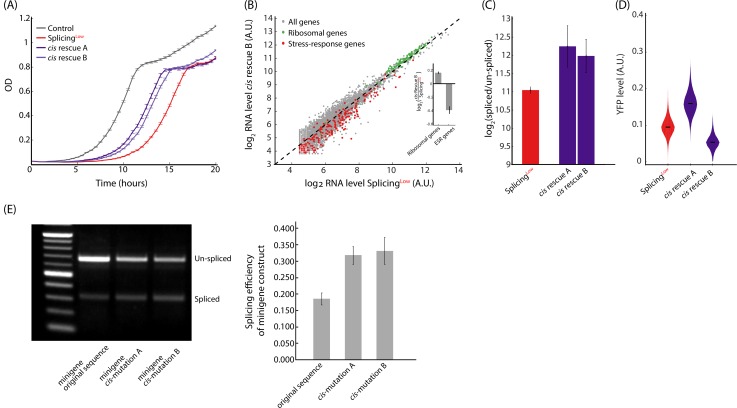
Cis-acting mutations are sufficient to increase fitness by elevating splicing efficiency.(A) We created two Cis-rescue strains, each harboring one of the mutations that appeared spontaneously in the evolved populations. Growth of the two Cis-rescue strains show that a single mutation in the YFP-Kan construct is sufficient to increase fitness compared with SplicingLow. (B) The exonic mutation is also sufficient to alleviate stress, as ribosomal genes were up-regulated (green dots, p = 1.02 × 10−18, paired t test) and stress-related genes were down-regulated (red dots, p = 9.02 × 10−12, paired t test) in cis-Rescue-B compared with SplicingLow. The same trend was also observed for the intronic mutation for cis-Rescue-A cells. (Inset) Mean log2 ratio of ribosomal and ESR gene groups. (C) The two Cis-rescue strains demonstrate higher splicing efficiency of the YFP-Kan mRNA compared with the SplicingLow ancestor (p < 0.05). This result suggests that a single mutation is sufficient to improve splicing efficiency. (D) Fluorescence intensity of the YFP-Kan reporter for the cis-Rescue-A and cis-Rescue-B strains show similar trends as the colonies in Fig 3D—supporting earlier conclusions. (E) The effects of Cis mutations on splicing tested with a mini-gene approach. We cloned the intron’s original sequence and its two mutated versions together with 200 bps surrounding it into a high–copy number plasmid. RT-PCR assays for WT (BY4741) cells transformed with these plasmids show that, even in this context, the Cis mutations are sufficient to increase splicing efficiency of the intron for both mutated intron versions compared with the original sequence (p < 0.05, t test). See numerical data for this figure in S1 Data. WT, wild-type.